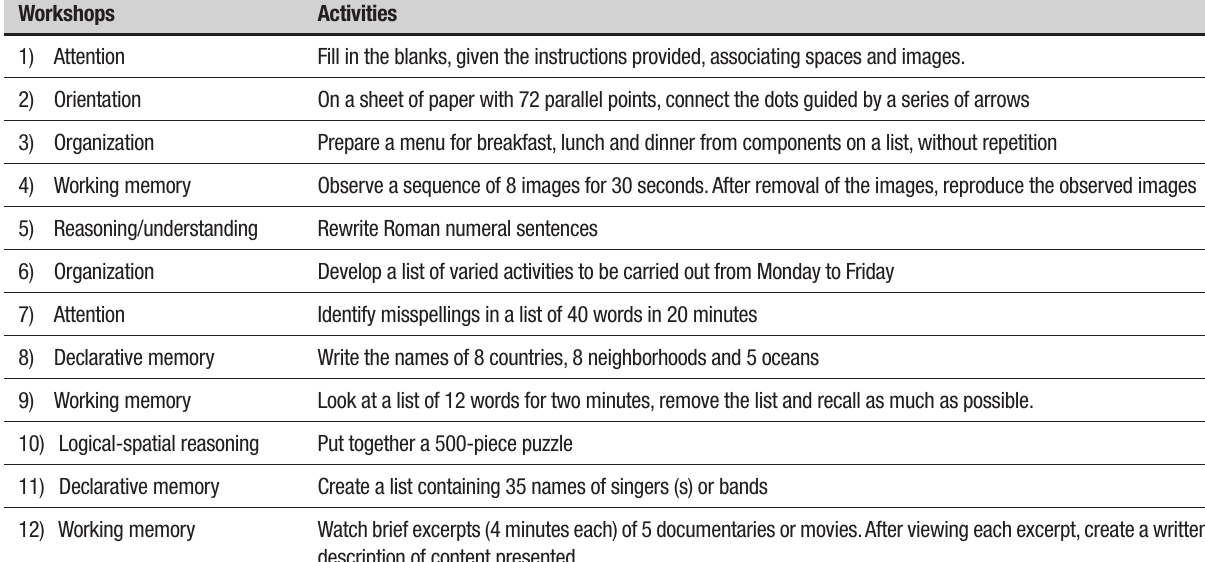
Table 1. Description of the activities conducted in workshops for both groups.